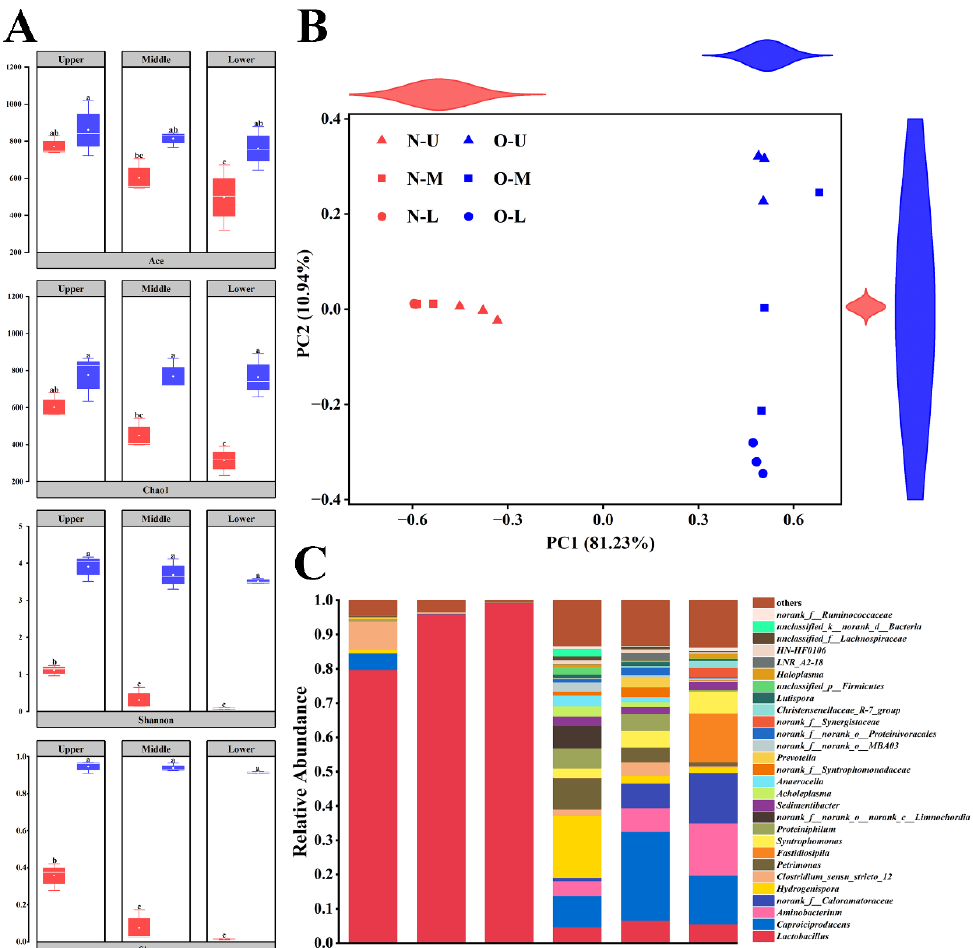
Figure 1. ( A ) Alpha-diversity of the bacterial communities (at the level of operational taxonomic unit [OTU]) present in new (red) and old (blue) pit-wall mud (PWM) samples. Considerable differences among various PWM samples are denoted by letters (abc) above the error bar. ( B ) Principal coordinate analysis (at the OTU level) performed using the weighted_unifrac distance matrix (R = 0.780; p = 0.001). ( C ) Composition of the bacterial communities (at the genus level) found in various PWM samples. N and O indicate new (3-year-old) and old (30-year-old) PWM samples, respectively. U, M, and L indicate the upper, middle, and lower layers of PWM,